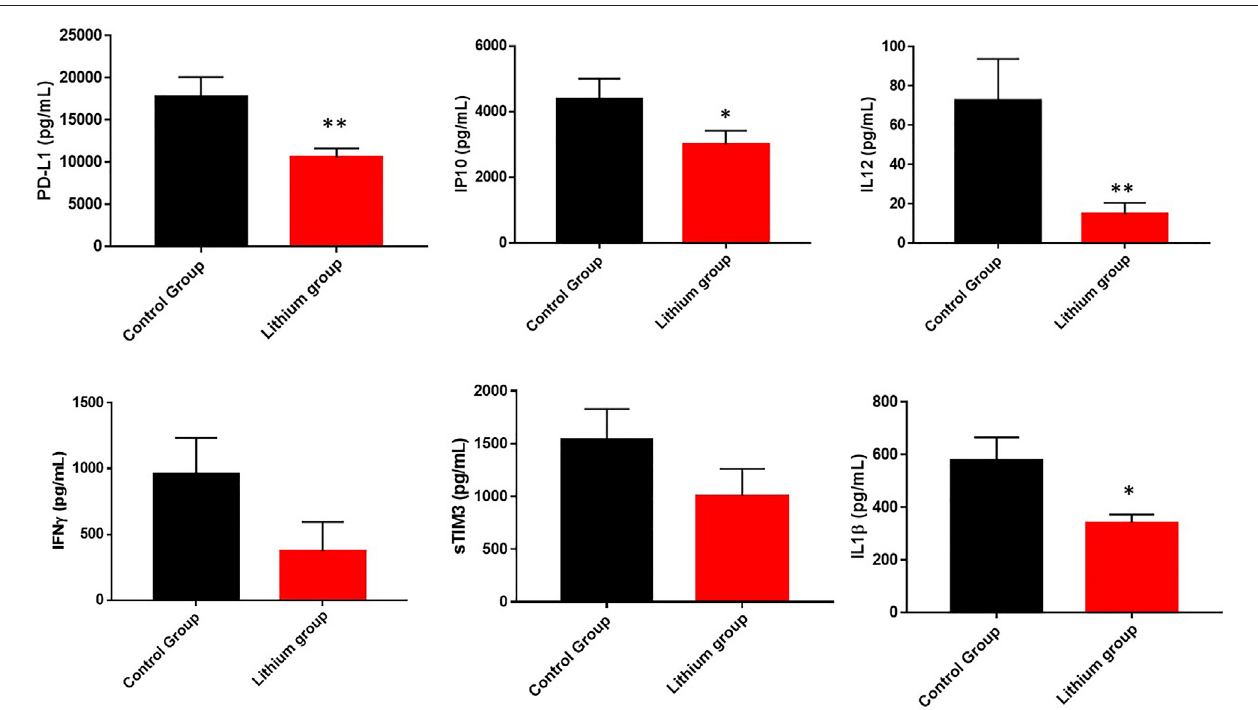
FIGURE 4 | Representation of cytokine levels involved in acute in fl ammation (sTIM3, PD-L1, IP10, IL12, IFN γ and IL1 β ). These graphs showed the reduction of acute in fl ammation in the group of patients treated with lithium. The graphs represent the area under the curve of cytokine levels measured during the study. * p < 0.05 and ** p < 0.01. In the case of IFN γ and sTIM3, there is a clear trend in the reduction of its levels in the group treated with lithium, although it is not signi fi cant ( p = 0.10).